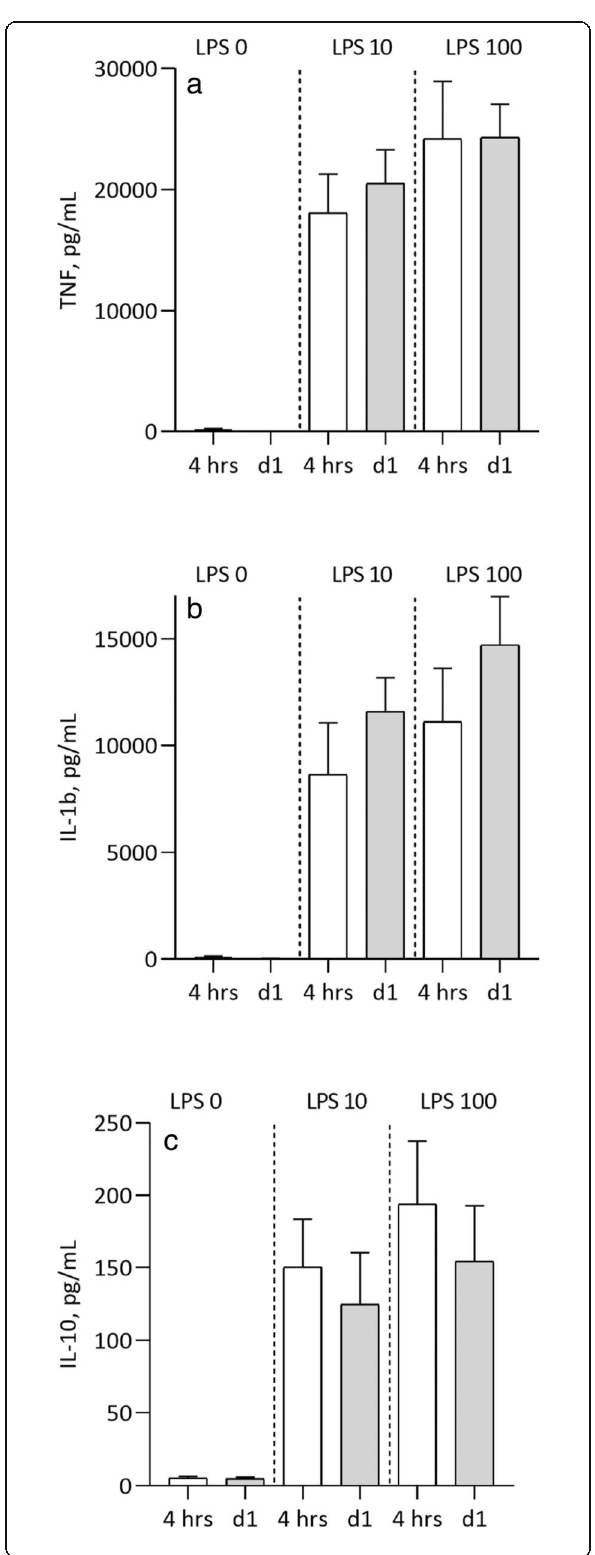
Fig. 3 DC. Whole blood stimulated with LPS-concentration 0, 10 and 100 ng/mL. Plasma levels of cytokines after 4 hours incubation in 37C ˚ before coronary angiography at 1 day after coronary angiography TNF ( a ), IL-1b ( b ), IL-10 ( c ). Data presented as median and (10-90)